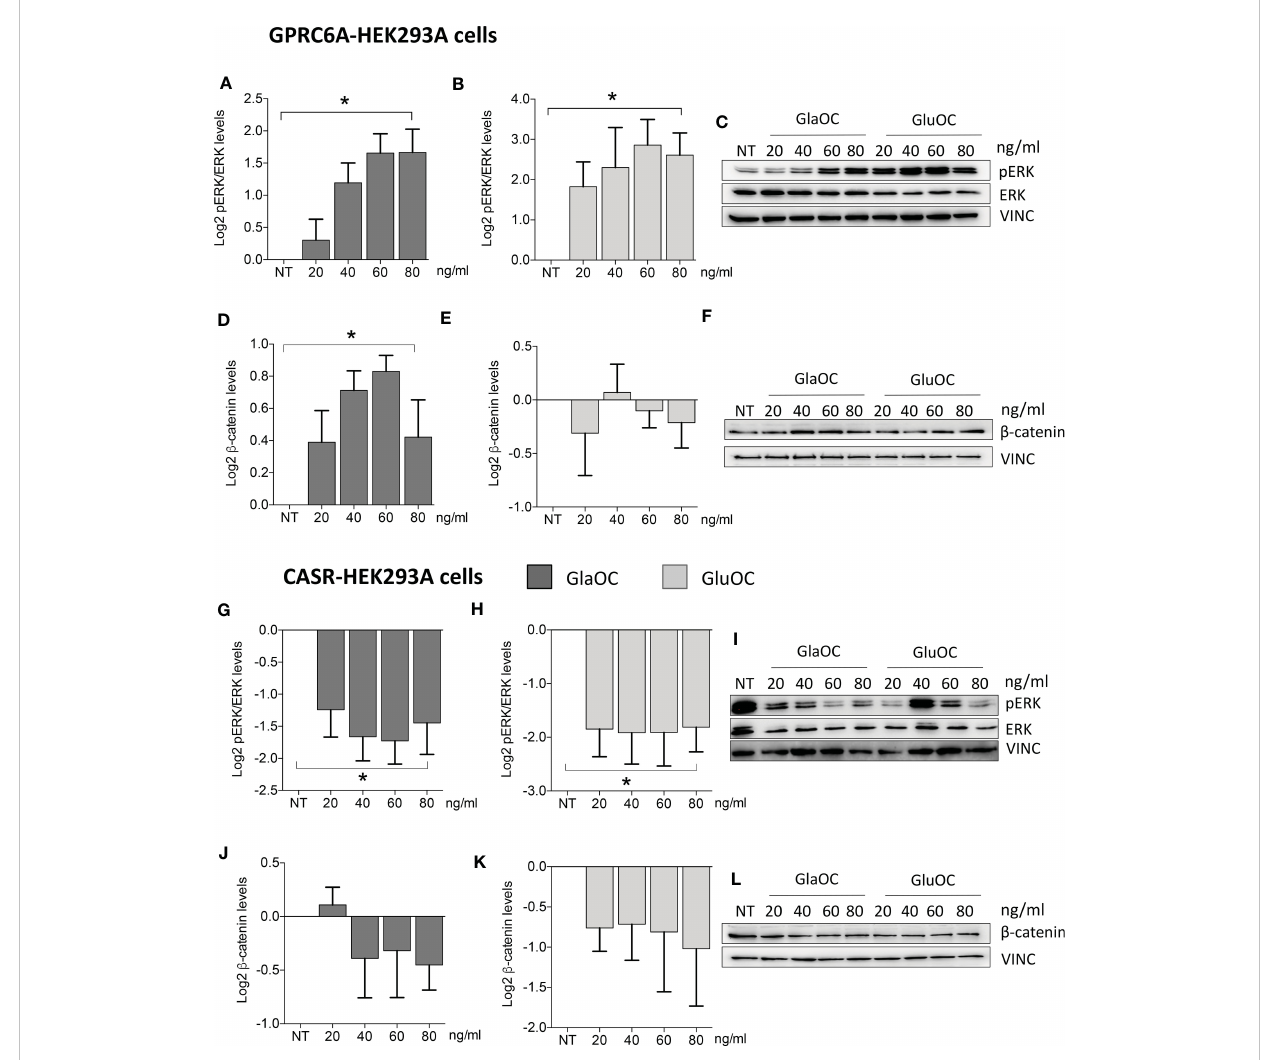
FIGURE 5 Effects of the treatment with GlaOC or GluOC in HEK293A cells transfected with GPCR6A and with CASR. HEK293A cells transiently transfected with GPRC6A (GPRC6A-HEK293A) or CASR (CASR-HEK293A) were incubated for 10 minutes with increasing concentrations (20, 40, 60, 80 ng/mL) of GlaOC (dark grey columns) and GluOC (light grey columns). Data were log2 transformed and presented as mean±SEM. (A, B) Effects of increasing concentrations of GlaOC and GluOC on pERK/ERK levels (*, P=0.006 and P=0.05, respectively) in GPRC6A-HEK293A cells. (C) Representative western blot. (D, E) Effects of increasing concentrations of GlaOC and GluOC on active b -catenin levels (*, P=0.025) in GPRC6A-HEK293A cells and representative western blot (F) . (G, H) Effects of increasing concentrations of GlaOC and GluOC on pERK/ERK levels (*, P=0.023 and P=0.048, respectively) in CASR-HEK293A cells and representative western blot (I) . ( J, K) Effects of increasing concentrations of GlaOC and GluOC on b - catenin levels in CASR-HEK293A cells and representative western blot (L)